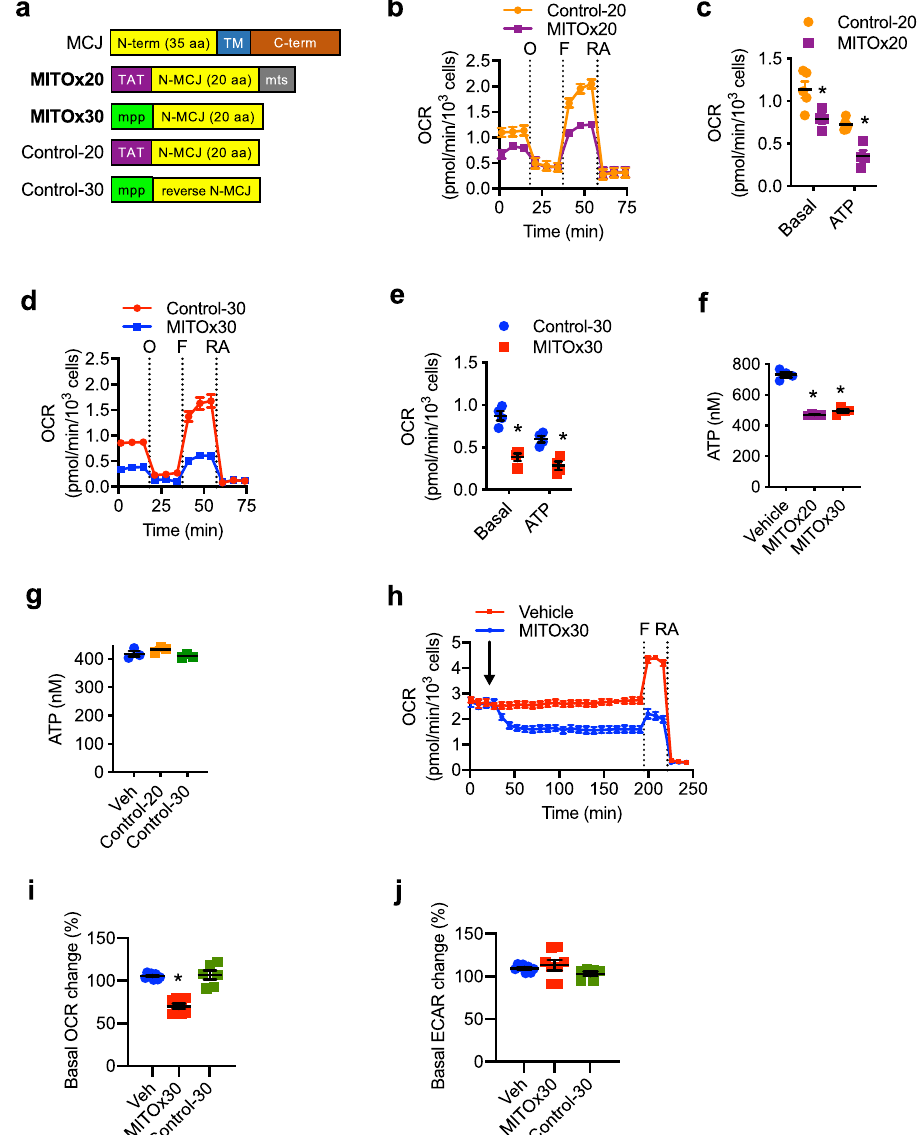
Fig. 5 N-MCJ mimetics attenuate mitochondrial respiration in chemoresistant cancer cells. a Diagram of N-MCJ mimetics. Top diagrams show full length MCJ (not to scale). N-term, N-terminus; TM, transmembrane domain; C-term, C-terminus; TAT, HIV TAT sequences; N-MCJ, fi rst 20 aa of the MCJ N-terminus; mts, mitochondrial targeting sequence; mpp, mitochondrial penetrating peptide; rev, reversed aa sequence. b , c NCI/ADR-RES cells were treated with MITOx20 (25 μ M) or Control-20 (25 μ M) for 12 h and the analyzed by Seahorse MitoStress Assay for b oxygen consumption rates (OCR) at baseline and in response to sequential injections of oligomycin (O), FCCP (F), and rotenone with antimycin (RA) and for c basal (Control n = 5, MITOx20 n = 4) and ATP-linked (ATP) (Control n = 5, MITOx20 n = 4) relative to Control-20 treated cells. p = 0.0243, 0.001 by unpaired t test. d , e NCI/ADR-RES cells were treated with MITOx30 (25 μ M) or Control-30 (25 μ M) for 12 h and then analyzed as in ( b , c ) ( n = 4). p = 0.0005, 0.002 by unpaired t test. f NCI/ADR-RES cells were incubated with or without (Vehicle) MITOx20 (25 μ M) or MITOx30 (25 μ M) for 5 h and then total ATP levels were determined by Luciferase assay ( n = 4). p = 0.0001, 0.0001 by one-way ANOVA and Tukey ’ s multiple comparisons test. g NCI/ADR-RES cells were incubated with or without (Vehicle) Control-20 (25 μ M) or Control-30 (25 μ M) for 5 h and then total ATP levels were determined by Luciferase assay ( n = 3). p = 0.3635, 0.7322 by one-way ANOVA and Tukey ’ s multiple comparisons test. h NCI/ADR-RES cells were analyzed for OCR at baseline and in response to sequential injections of MITOx30 (25 μ M), FCCP, and rotenone with antimycin. i Basal OCR ( p = 0.0001, 0.9681 by one-way ANOVA and Tukey ’ s multiple comparisons test), j and ECAR ( p = 0.7301, 0.4473 by one-way ANOVA and Tukey ’ s multiple comparisons test) in NCI/ADR-RES cells in response to injection of MITOx30 or Control-30 as determined by MitoStress assay (vehicle n = 8, Control-30 n = 6, MITOx30 n = 8). Mean ± SEM is shown for all fi gures. * denotes p < 0.05 by unpaired t test or one-way ANOVA and Tukey ’ s multiple comparisons test. Results are representative of at least two (Fig. 6e). Similarly, the combination of doxorubicin and Control- also enhanced the response of NCI/ADR-RES cells to doxorubicin 30 had no effect on cell survival (Fig. 6e). In contrast, the after 2 d (Fig. 6f). N-MCJ mimetics did not have an effect on the combination of doxorubicin with MITOx30 markedly reduced response to doxorubicin in chemosensitive cancer cells like MCF7 NCI/ADR-RES cell viability (Fig. 6e). Treatment with MITOx20 or OVCAR cells (Supplementary Fig. 15a and b). To assess